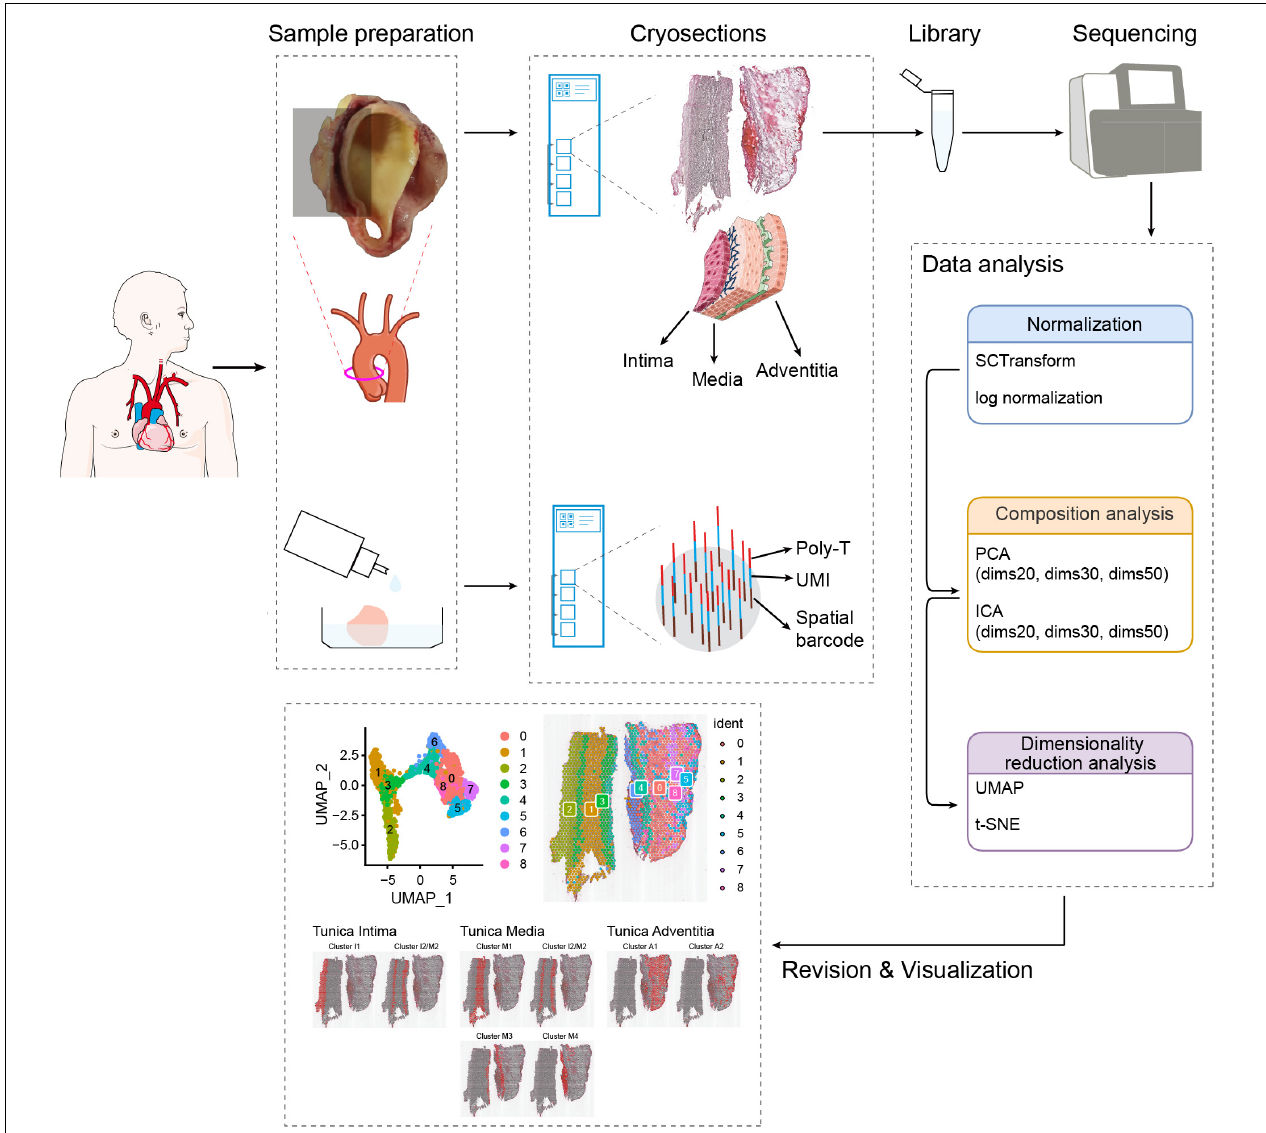
FIGURE 1 | Study design for ST in aortic dissection. Tissue of aortic dissection from the patient was dissociated and embedded in OCT; a fresh thin tissue section was obtained from cryosection, which was attached and fixed to each spot on the microarray slide; the library was sequenced and further processed to map the expressed genes to the spatial locations at which they were expressed; establishment of data analysis methods and visualization of cell populations.